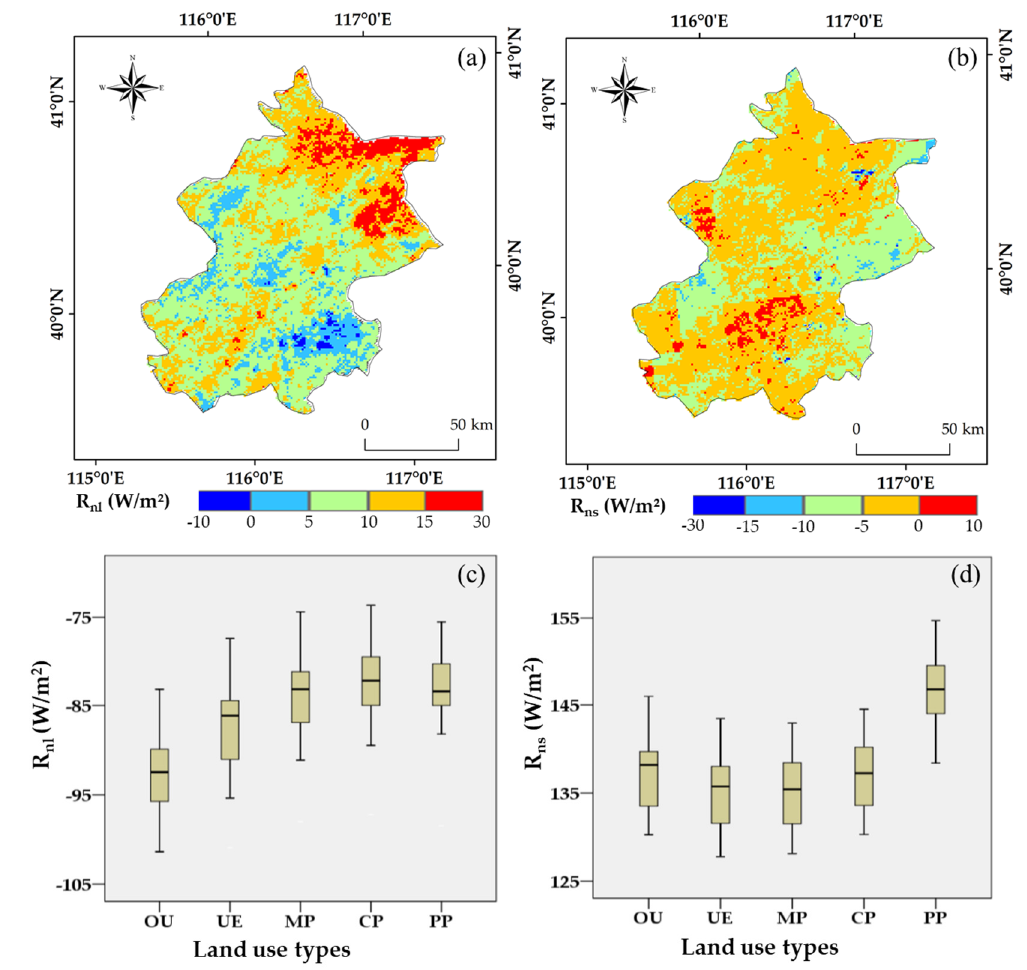
Figure 3. Net longwave and shortwave radiation in Beijing. Spatial differences of ( a ) net longwave radiation (R nl ) and ( b ) shortwave radiation (R ns ) from 2000 to 2015; statistical feature values of the five land use types for ( c ) R nl and ( d ) R ns from 2000 to 2015.